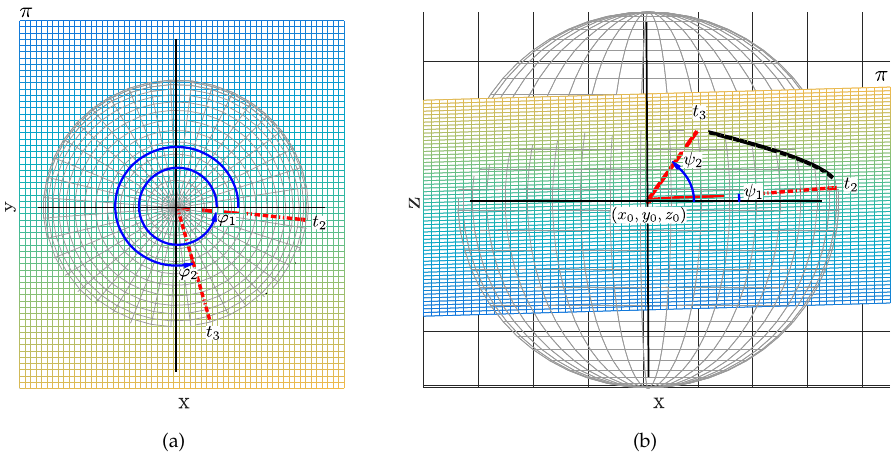
Figure 3. Spherical smooth path, where the black line shows the curve in a segment S i along the plane π i . The red lines show the union from the center of coordinates of the sphere to the points of intersection between the sphere and the π i plane resulting in the spherical semicurve. ( a ) View perpendicular to the horizontal plane ( x , y ) . ( b ) Perpendicular view to the vertical plane ( x , z )